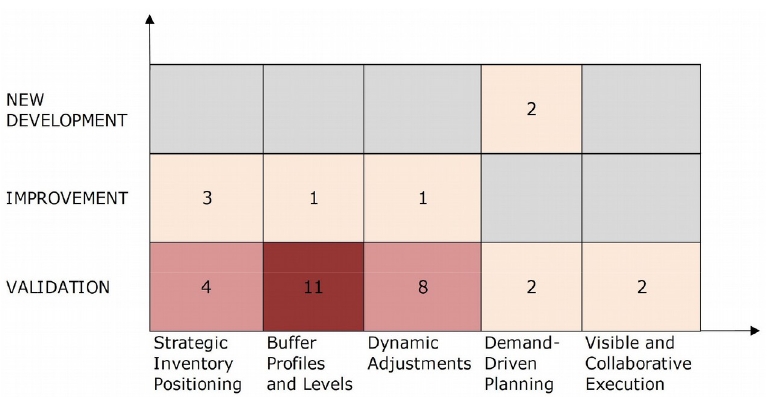
Figure 4. Summary of the matrix analysis based on the number of papers